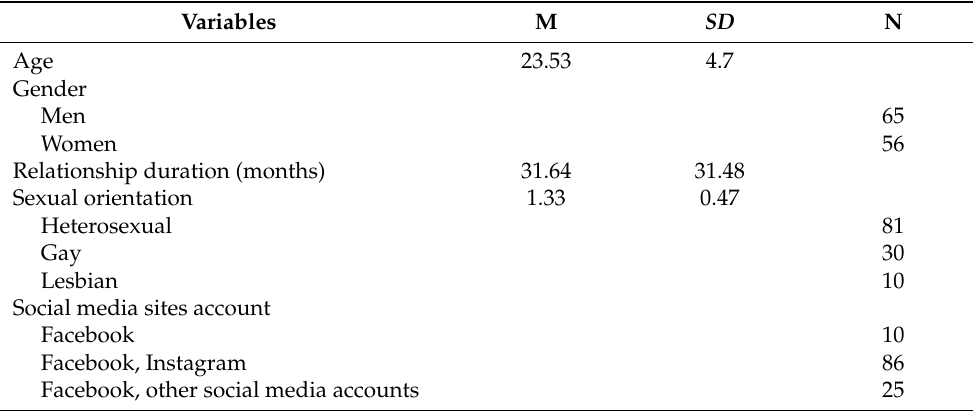
Table 1. Sociodemographic characteristics of the